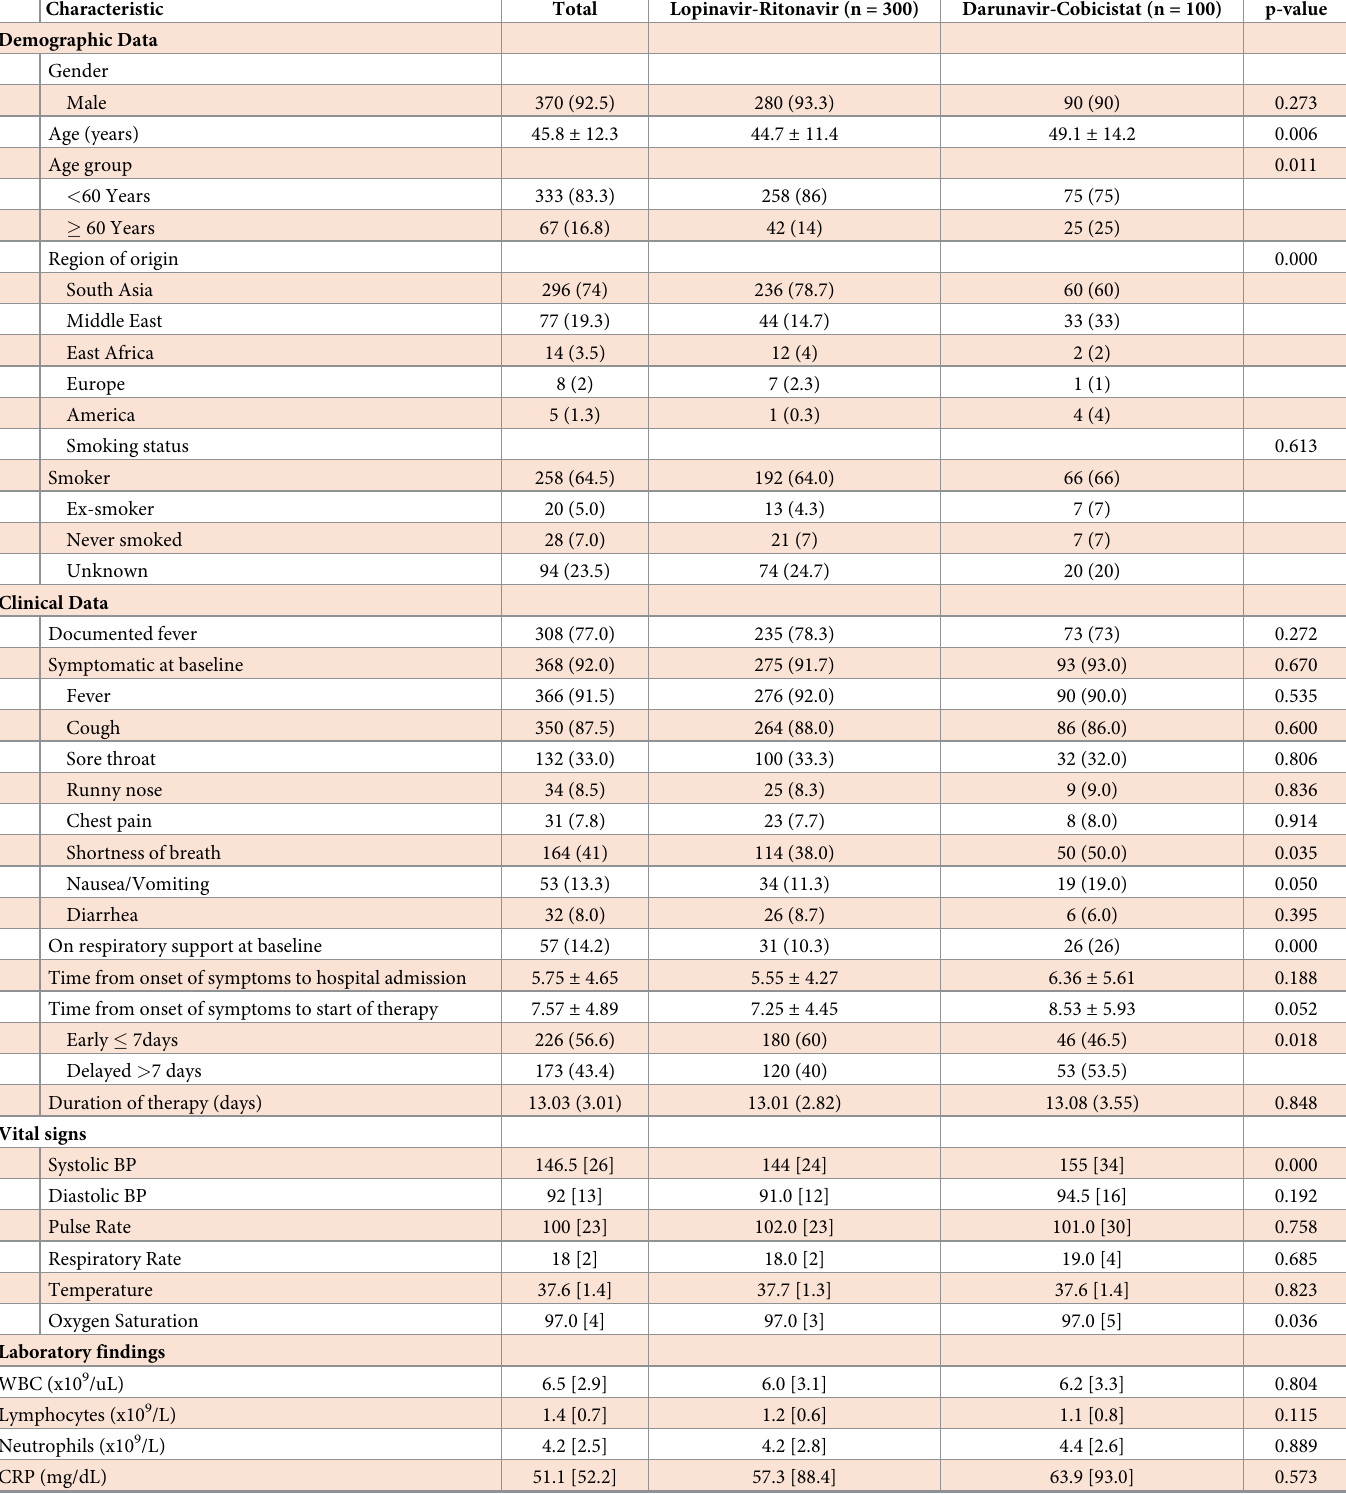
Table 1. Baseline characteristics of the study